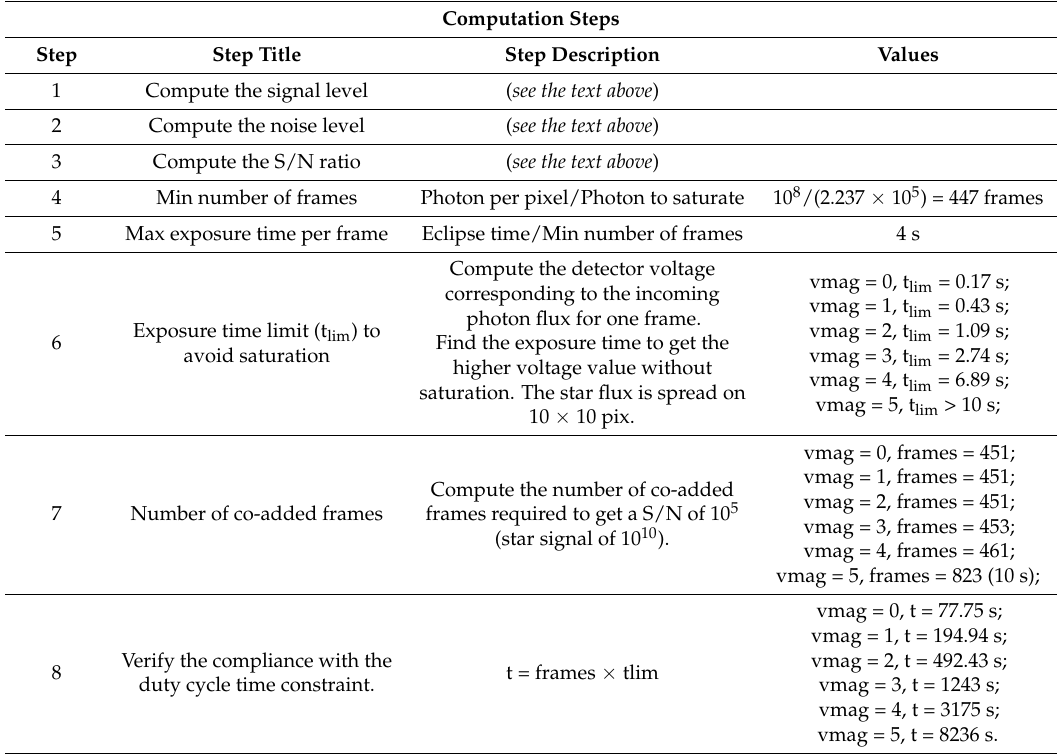
Table 6. Computation steps to determine the limiting V-magnitude.